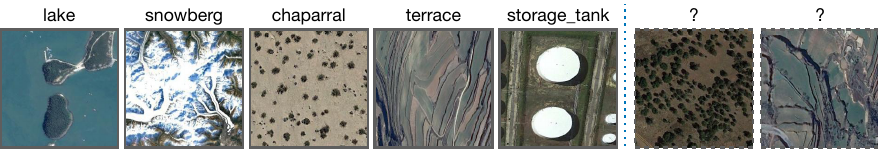
Figure 1. The One-shot Challenge: few-shot learning from one example. A single example of a new visual scene can be enough information for a child to classify new